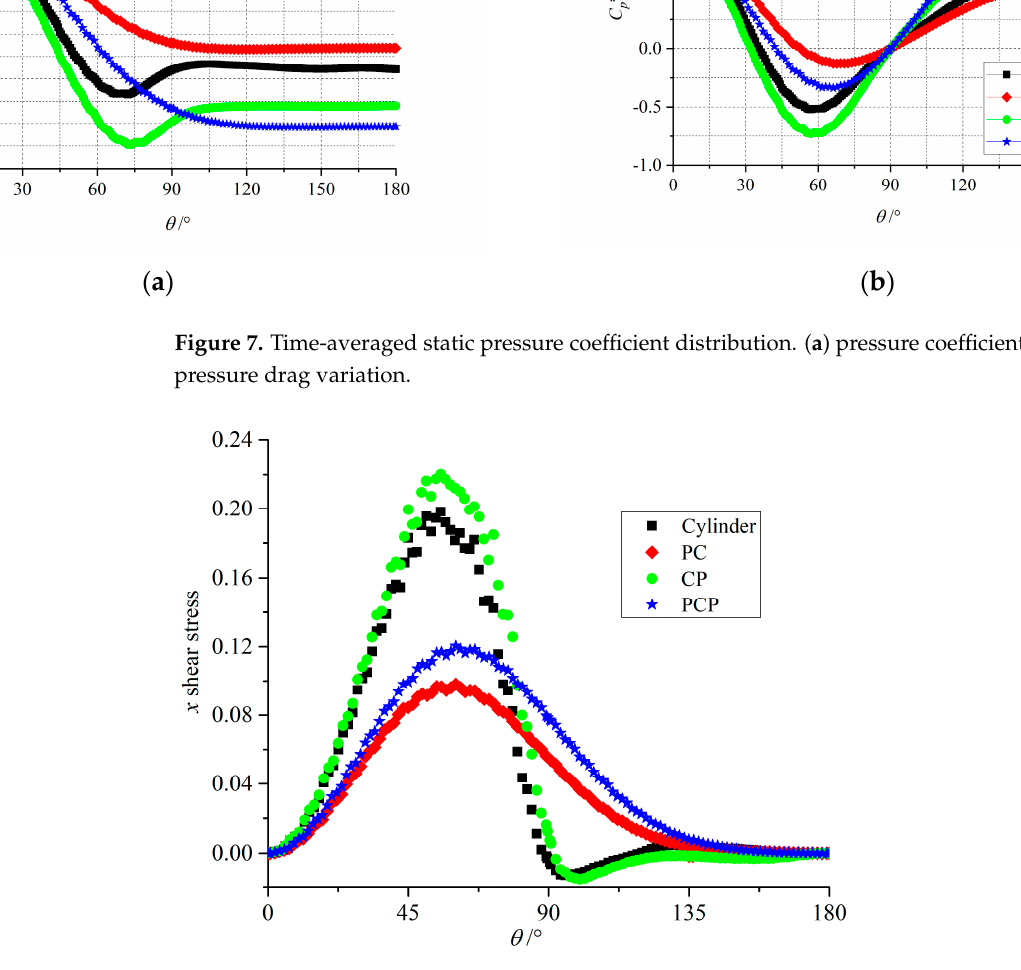
Figure 8. Time-averaged x-component shear stress on cylinder surfaces.